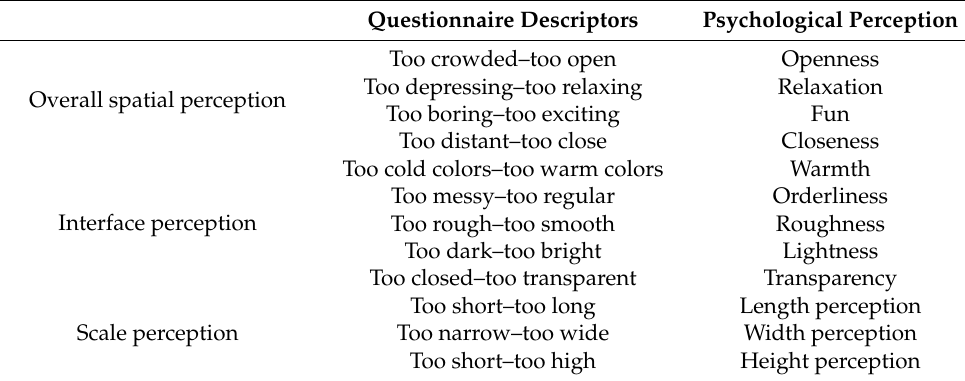
Table 1. Comparison of vocabulary and psychological perception. Questionnaire Descriptors Psychological Perception